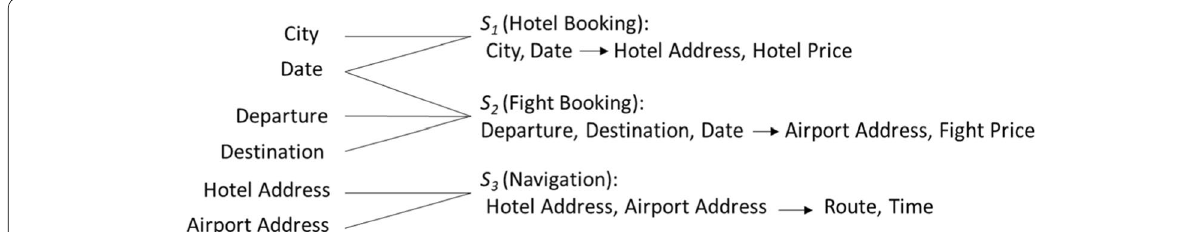
Fig. 2 The inverted index of three services used in Fig. 1